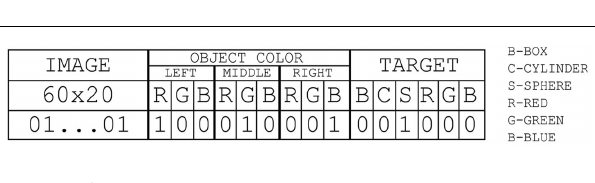
FIGURE 3 |The schema of the input vector for target localizer. In the simulations, the dimensionality of the object color and the target information was increased to counterbalance the effect of the high-dimensional image part. FIGURE 4 | Processing of the input image using the OpenCV